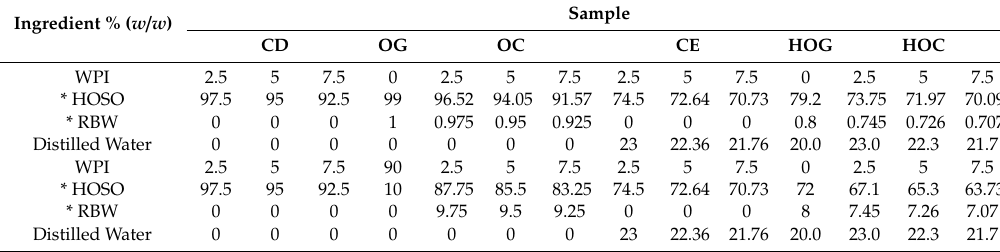
Table 1. Formulations of the colloidal dispersion (CD), oleogel (OG), oleocolloid (OC), colloidal emulsion(CE),hydro-oleogel(HOG),andhydro-oleocolloid(HOC)networkspreparedwith combinations of whey protein isolate (WPI), high oleic soybean oil (HOSO), rice bran wax (RBW), and distilled water. Ingredient % ( w / w )